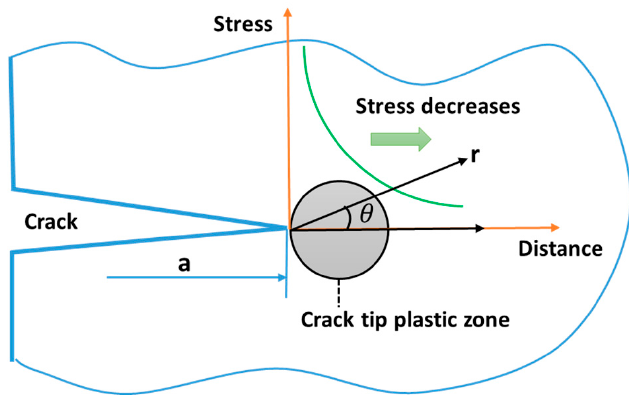
Figure 9. Stress around crack tip.